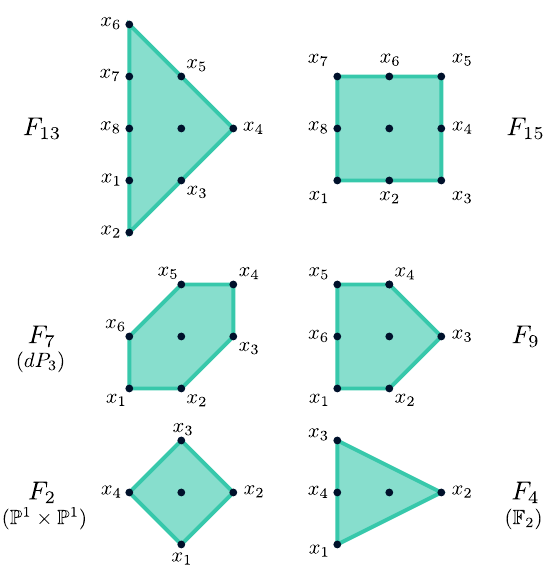
Figure 1 . The 6 re(cid:13)exive polytopes corresponding to toric base spaces B which lead to smooth elliptically (cid:12)bered CY three-folds and allow for an involution with at most (cid:12)xed points. The homogeneous coordinates x i associated to the rays are indicated and will be used throughout the paper.